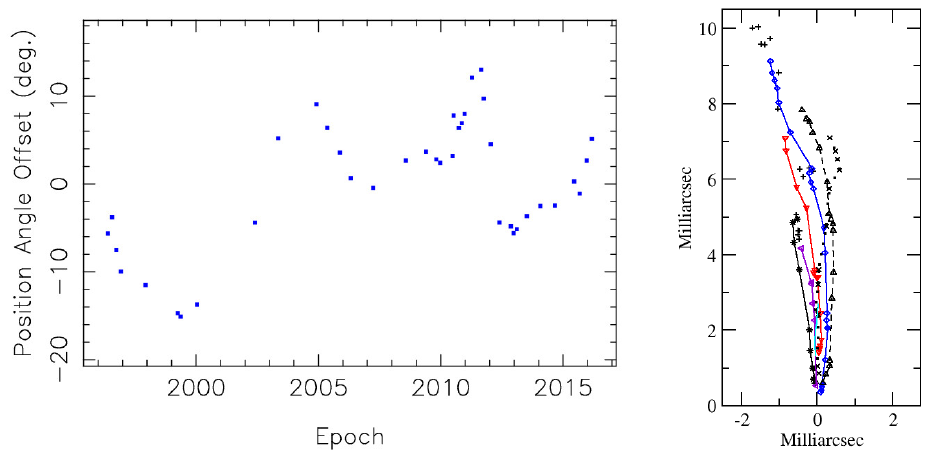
Figure 3. Left : Plot of inner jet position angle versus time for the quasar 1222+216, based on MOJAVE Very Long Baseline Array (VLBA) data; Right : Sky trajectories of moving features in this jet over a 15 year